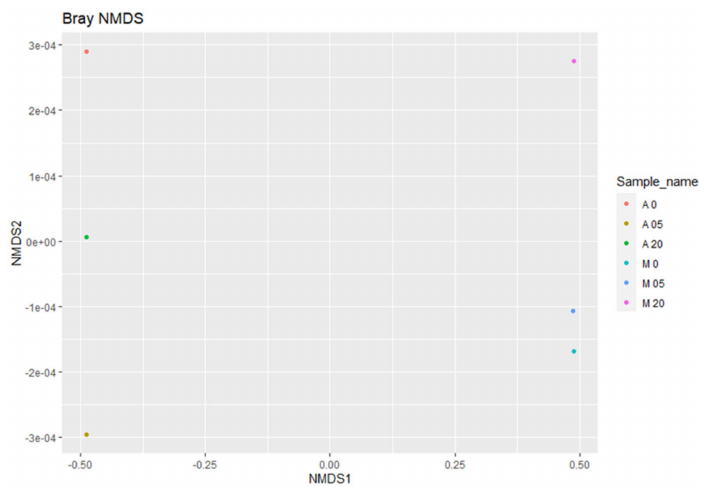
Figure 8. The Bray–Curtis NMDS plot showing the beta diversity of the fungal communities that were identified per